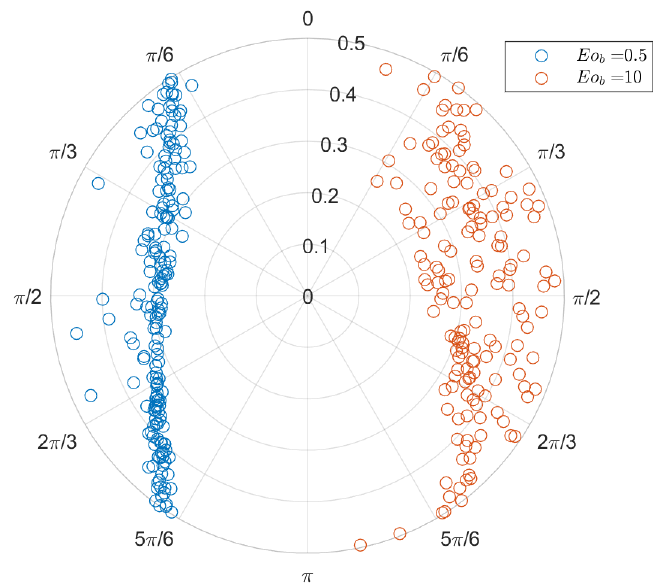
Figure 5. The relative location of the drops for 21 time samples for N d = 12. Eo b = 0.5 on the left and Eo b = 10 on the